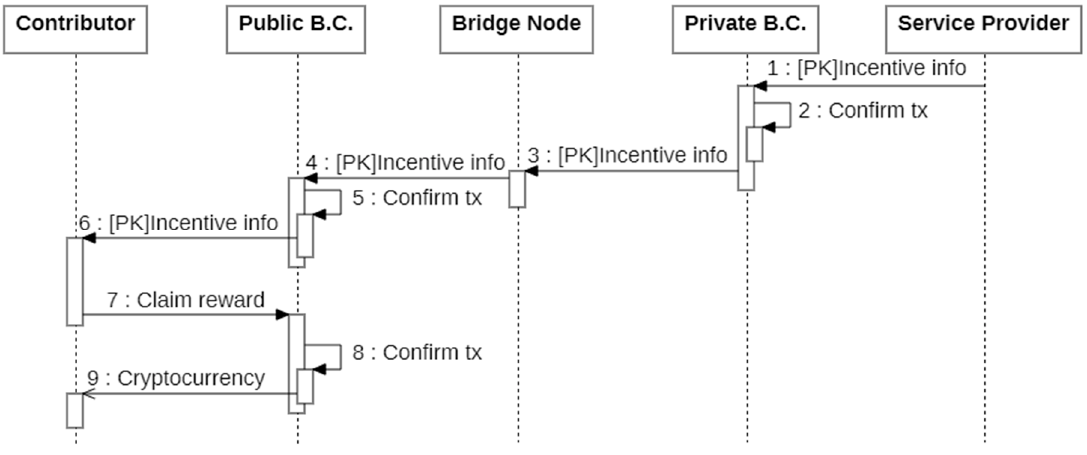
Figure 7. Sequence diagram for the reward.